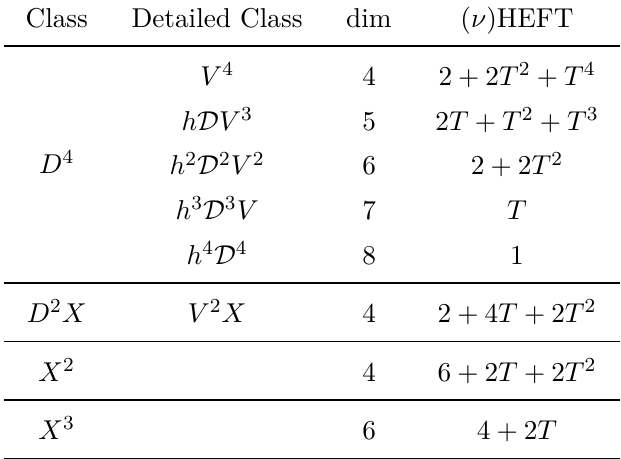
Table 6 . Spurion structure of the detailed breakdown of the eight classes of operators that are relevant for “NLO” ( ν )HEFT, bosonic sector.